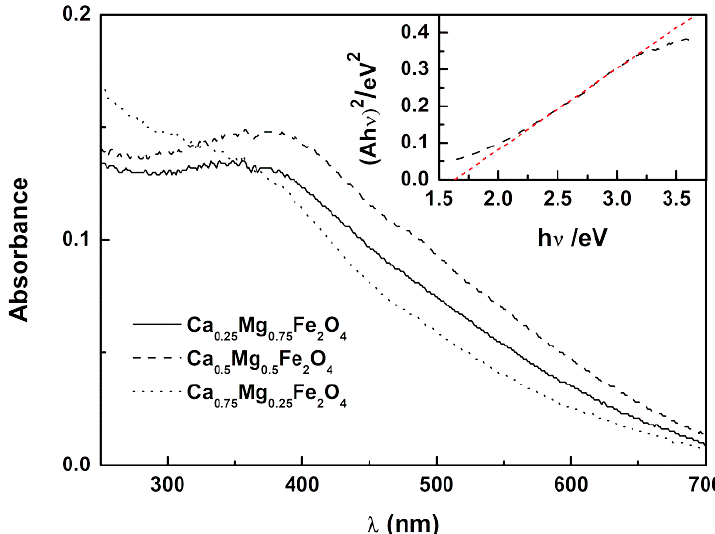
Figure 1. Absorption spectra of Ca 0.25 Mg 0.75 Fe 2 O 4, Ca 0.50 Mg 0.50 Fe 2 O 4 , and Ca 0.75 Mg 0.25 Fe 2 O 4 magnetic nanoparticles. Inset: Tauc plot for Ca 0.50 Mg 0.50 Fe 2 O 4 nanoparticles, as an example (red line is the linear